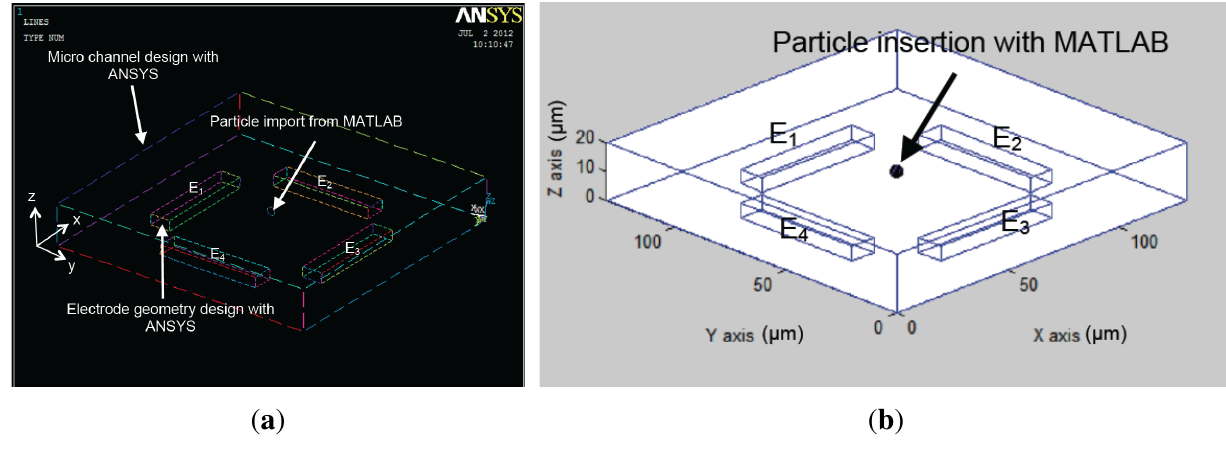
( a ) ANSYS electrode modeling and ( b ) MATLAB particle insertion in the micro-channel within an 8-electrode architecture.